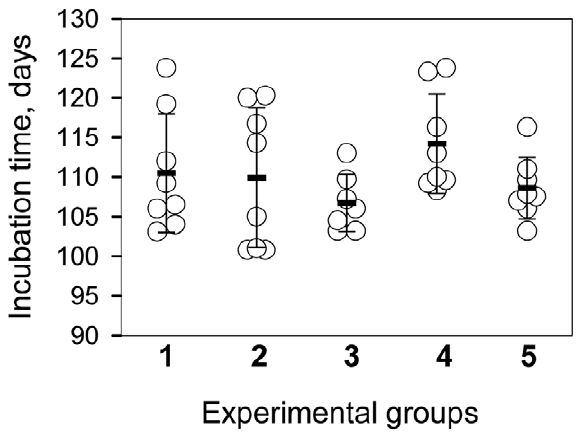
Figure 2. Bioassay of PMCA products. Incubation time to terminal disease stage in individual animals (circles) and in animal groups represented as mean 6 S.D. (black bars). Animals were inoculated with 10 2 4 -fold diluted 263K brain homogenate (group 1); 10 2 4 -fold diluted 263K brain homogenate sonicated for 48 cycles (a single PMCA round) in the absence of beads (group 2) or presence of 3 large beads (group 3) in the absence of NBH; and 10 2 4 -diluted 263K brain homogenate subjected to six serial PMCA rounds in the absence of beads (group 4) or presence of 3 large beads (group 5) using 1:10 dilutions between rounds. After serial PMCA, the amplification products were diluted an additional 10-fold to obtain 10 10 -fold dilutions of the original seeds for inoculating groups 4 and 5.